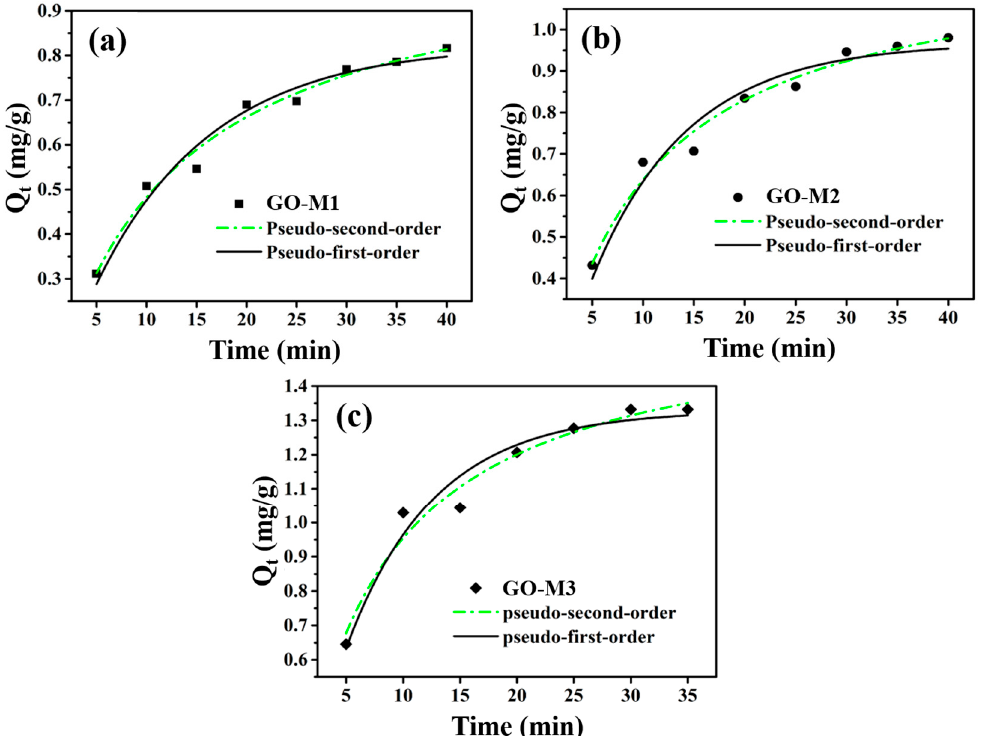
Figure 7. The adsorption kinetics curves of Cr(VI) adsorption by GO-M1 ( a ), GO-M2 ( b ) and GO-M3 ( c ) fitted with nonlinear pseudo-first-order kinetic and nonlinear pseudo-second-order kinetic models (reaction conditions: initial concentration of Cr(VI) 1 mg/L at pH 1, 20 mL of solution, 15 mg of adsorbent, 5~35/40 min, 298.15 K). Table 5. Calculation parameters of kinetics for the adsorption of Cr(VI) on GOs.